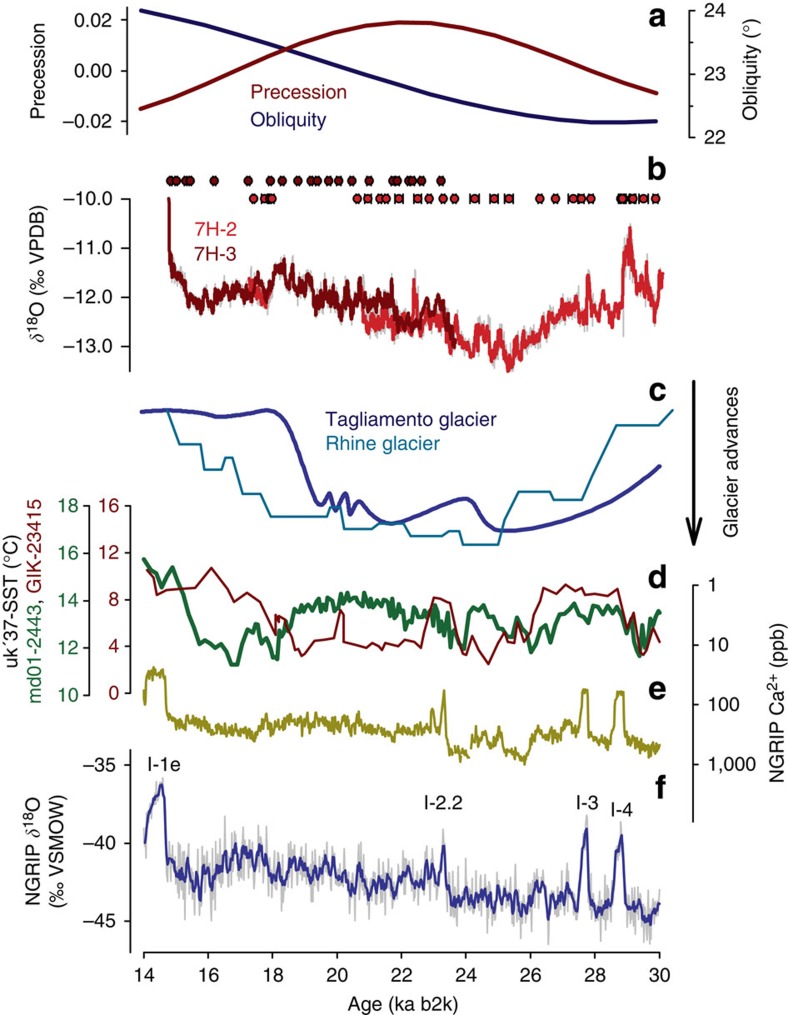
LGM data comparison.(a) Precession (brown) and obliquity (blue)23. (b) 7H-2 (red) and 7H-3 (brown) δ18O time series (21a low-pass filter) plotted with individual U/Th ages and measured errors (2σ). (c) Alpine glacier advances reconstructed for Tagliamento and Rhine glaciers1718. (d) North-eastern Atlantic sea-surface temperature1516. (e) NGRIP dust record33. (f) NGRIP δ18O with a 100a low-pass filter12.